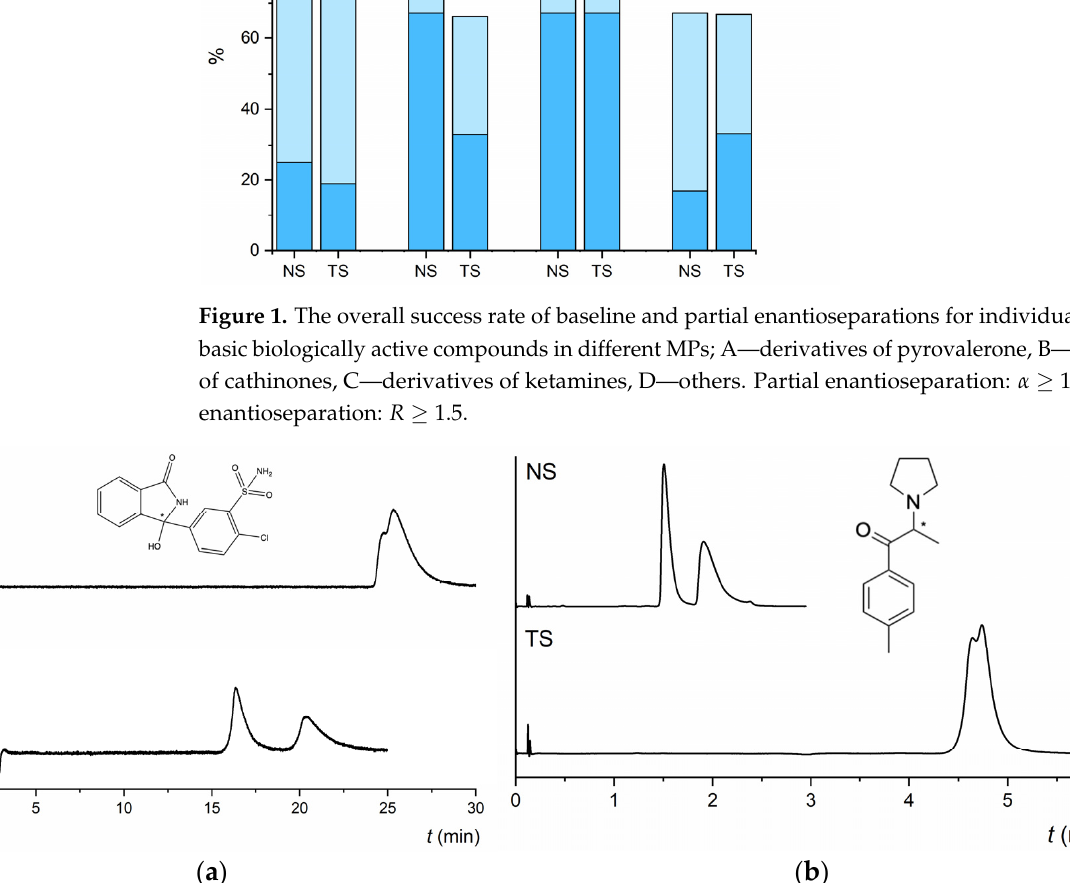
Figure 2. Chromatograms of enantioseparation of chlorthalidone ( a ) and M-PPP ( b ) on the NicoShell (NS) and TeicoShell (TS) columns. MP composition: CO 2 /MeOH/AcA/IPA (90/10/0.1/0.01, v / v / v / v ) on both columns. SFC conditions: flow rate 2.00 mL min − 1 ; column temperature 40 °C; BP 13.8 MPa; UV detection 254 nm. (*) in the structure indicates a stereogenic center.